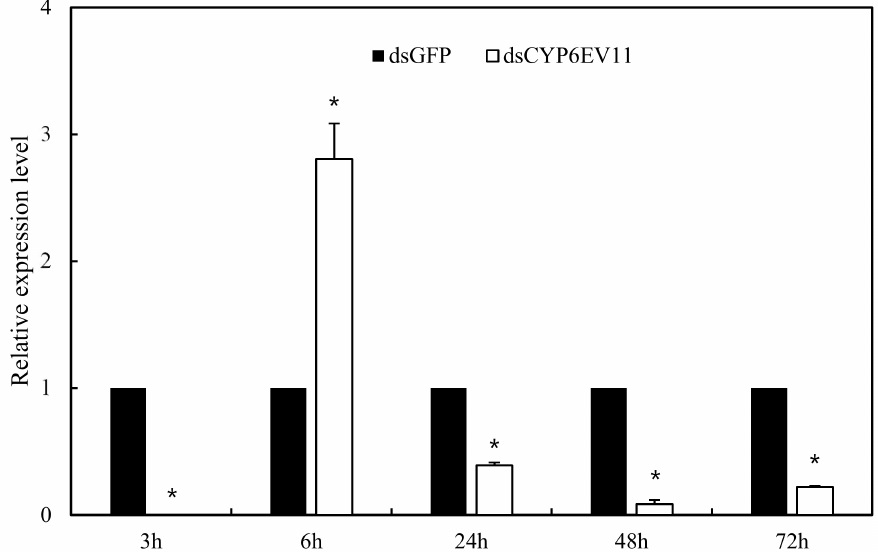
Figure 6. Transcriptional levels of CYP6EV11 in silenced C. kiiensis larvae in response to phenol stress. The larvae treated with dsGFP were regarded as control. The SE bars were calculated based on three experimental replicates. The asterisk (*) on the SE bars indicate significant differences between treatments and controls ( p < 0.05).